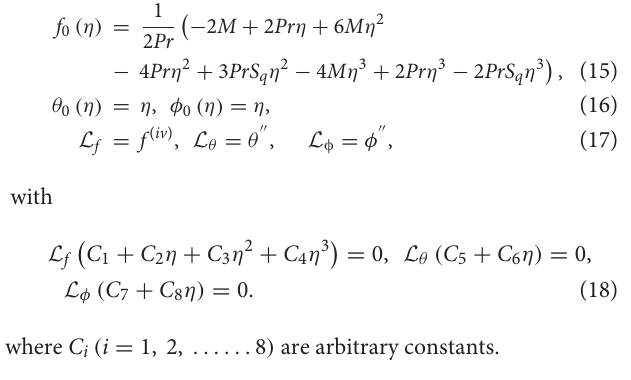
FIGURE 3 | Behavior of S q on f ′ ( η ).